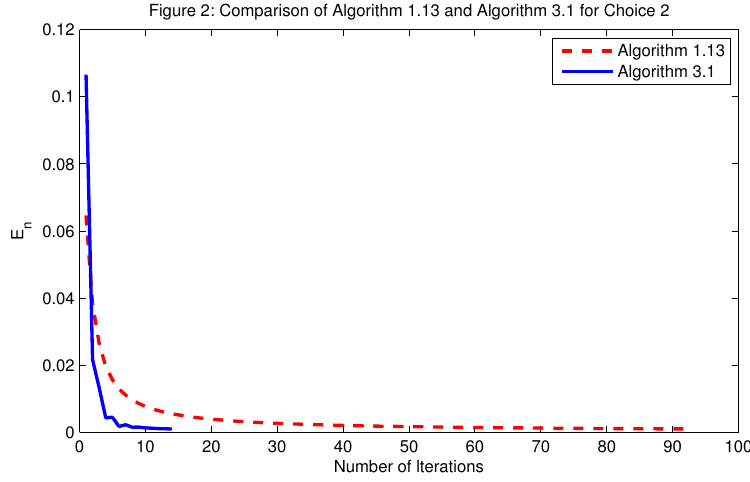
Figure 2: Comparison of Algorithm 1.13 and Algorithm 3.1 for Choice 2